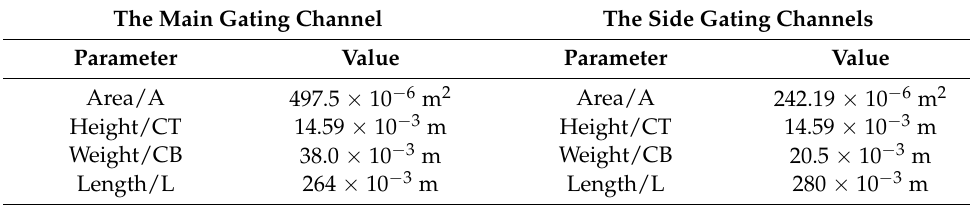
Table 6. Adjusted dimensions of gating channels.